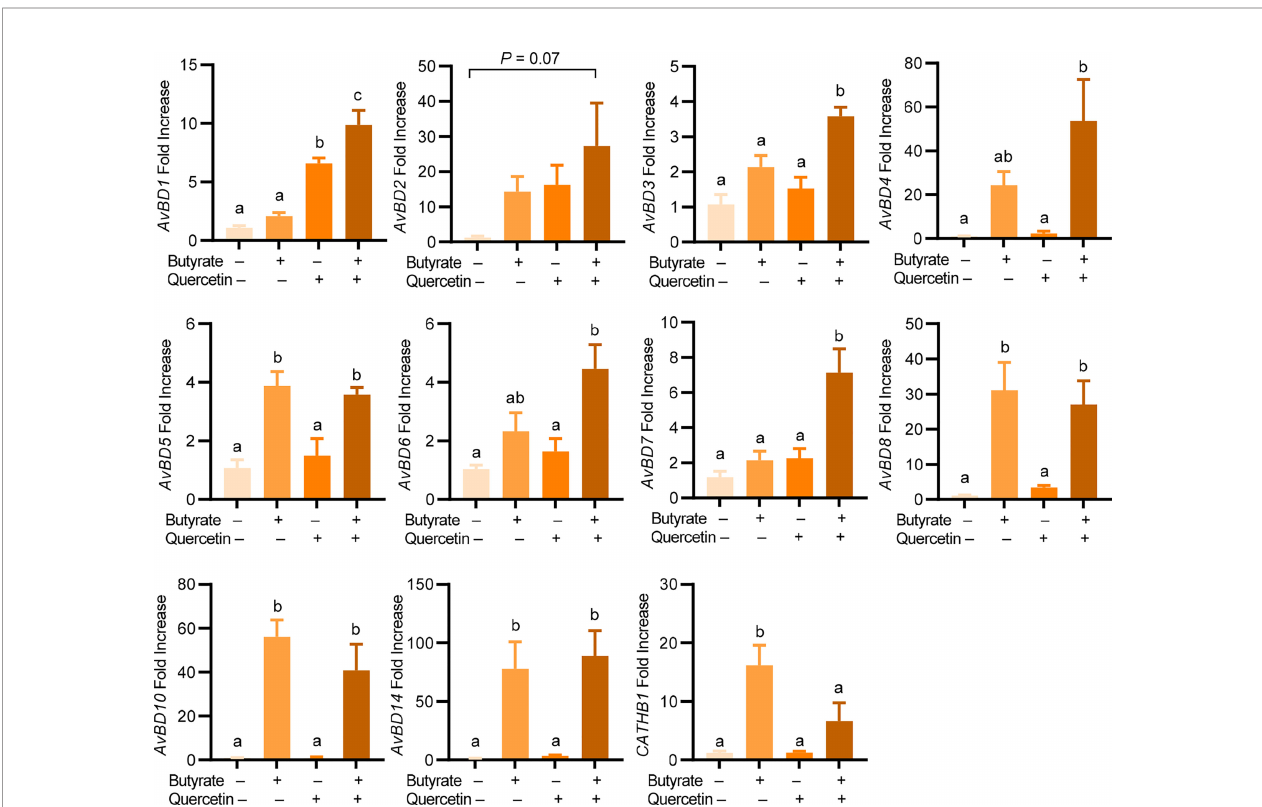
FIGURE 3 | Induction of chicken HDP genes by quercetin and butyrate. Chicken HTC macrophage cells were treated in duplicate with 20 m M quercetin and 2 mM sodium butyrate separately or in combination for 24 h, followed by RT-qPCR analysis of chicken HDP gene expression. Results are presented as means ± SEM of two independent experiments. The bars not sharing common superscript letters are signi fi cantly different ( P < 0.05) as determined by one-way ANOVA and post hoc Tukey ’ s